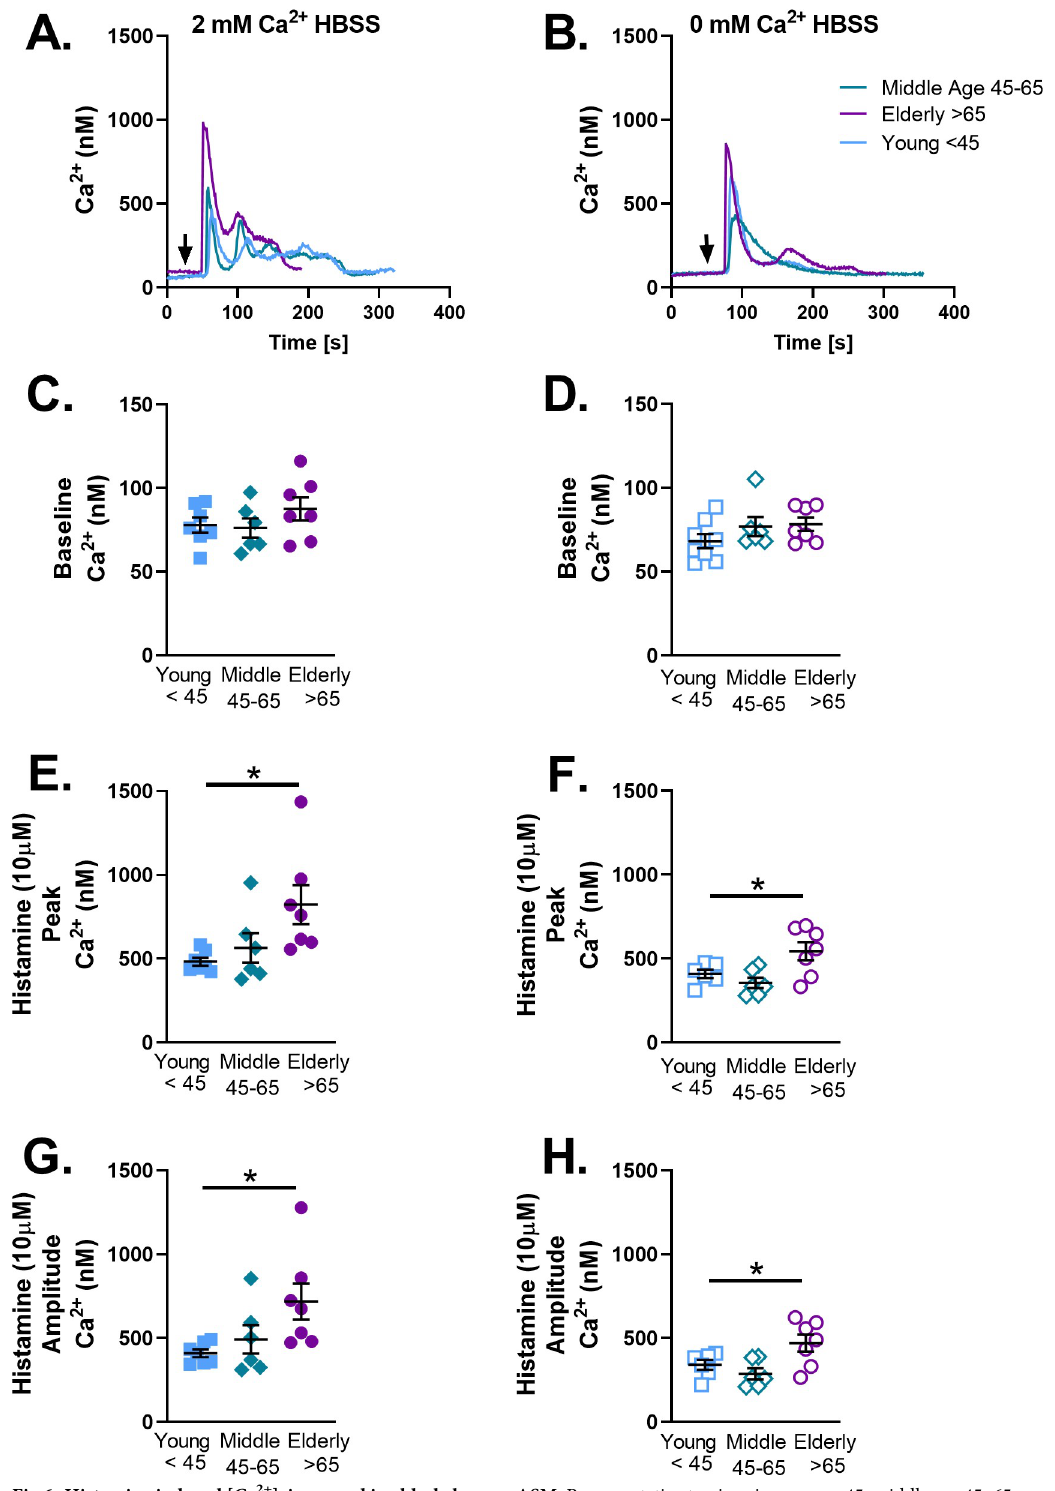
Fig 6. Histamine induced [Ca 2+ ] i increased in elderly human ASM. Representative tracings in young < 45, middle age 45–65, and elderly > 65 human ASM (A). Histamine (10 μ M, black arrow) was applied to Fura 2 AM loaded cells in 2 mM Ca 2+ HBSS. Baseline [Ca 2+ ] i was not changed with age(C). After histamine peak (E) and amplitude (G) of [Ca 2+ ] i was increased in elderly ASM. To measure changes in [Ca 2+ ] i release following contractile agonist stimulation independent of influx in ASM histamine